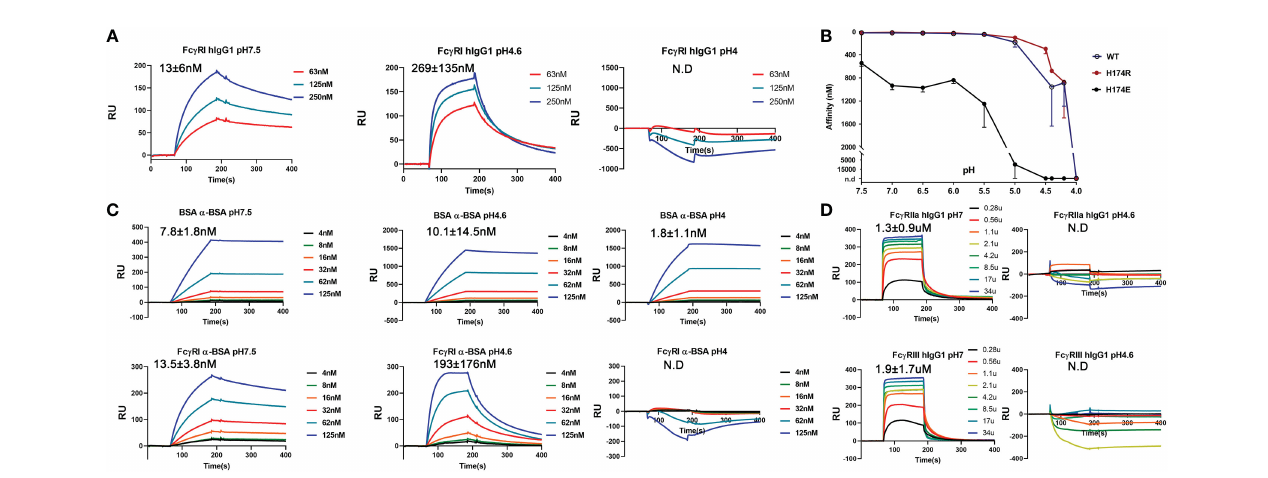
FIGURE 6 pH sensitive binding between Fc g RI and IgG. (A) Binding of Fc g RI to IgG 1 at pH 7.5, 4.6 and 4.0. (B) pH-titration of the Fc g RI wildtype, H174R and H174E mutants binding to IgG 1 . (C) Binding of BSA and Fc g RI to rabbit polyclonal anti-BSA antibody at pH7.5, 4.6 and 4.0. (D) Binding of Fc g RII and Fc g RIII to IgG 1 at pH7 and